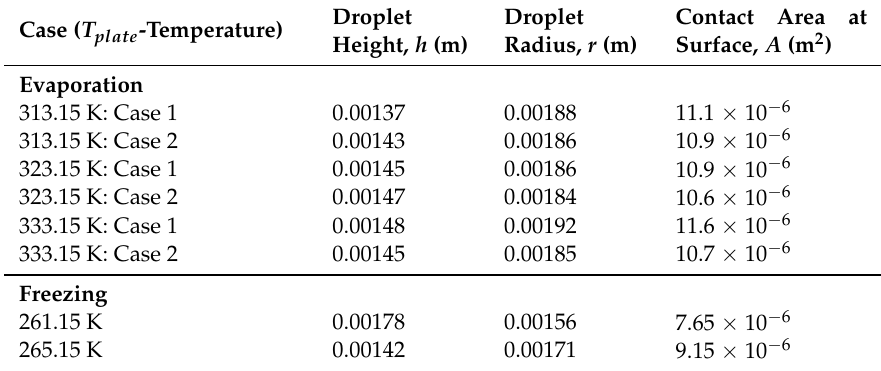
Table 3. Values of the geometries of the evaporating and freezing droplets at t = 1